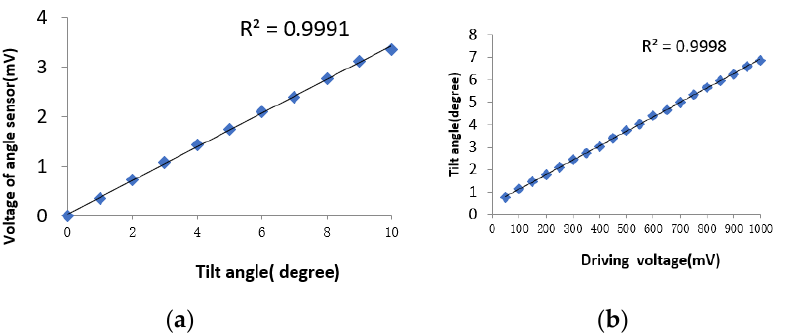
Figure 14. The test of the MOEMS scanning grating mirror. ( a ) Voltage of angle sensor vs. tilt angle. ( b ) Tilt angle vs. driving voltage.